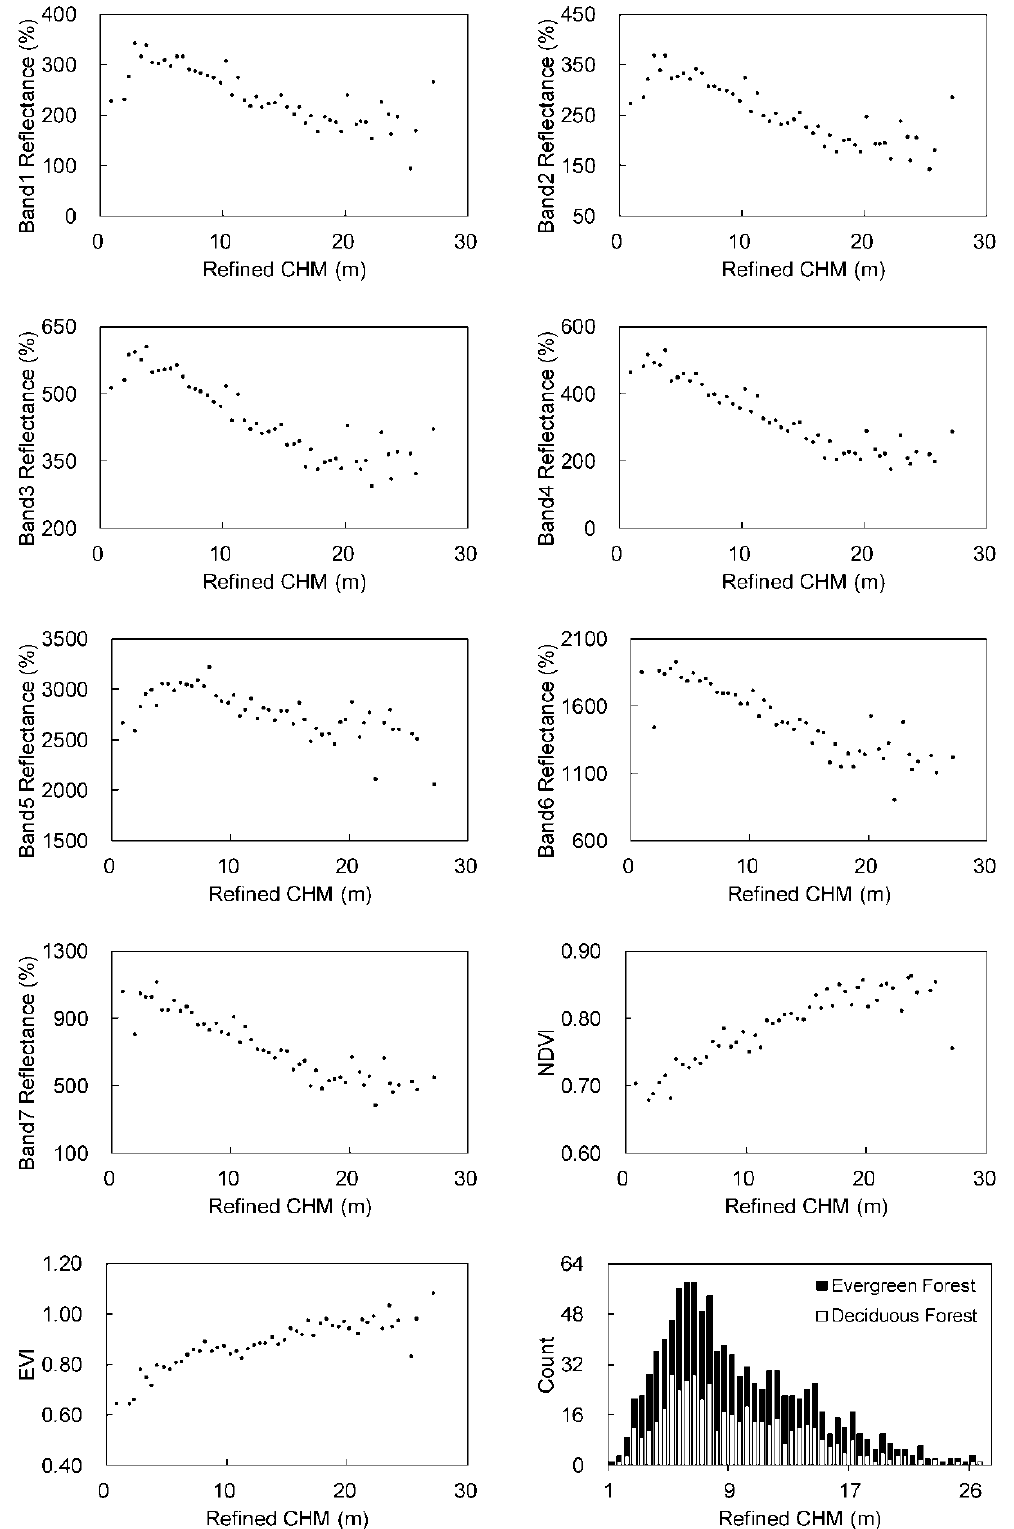
Figure A1. Scatter plots of the piecewise averaged predictor variables and refined CHM.